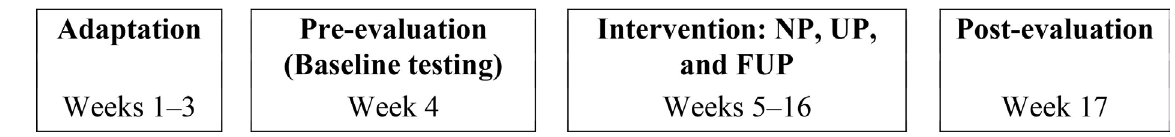
Figure 1 - Experimental design: NP: Non-Periodized group; UP: Undulating Periodization Group; FUP: Flexible Undulating Periodization